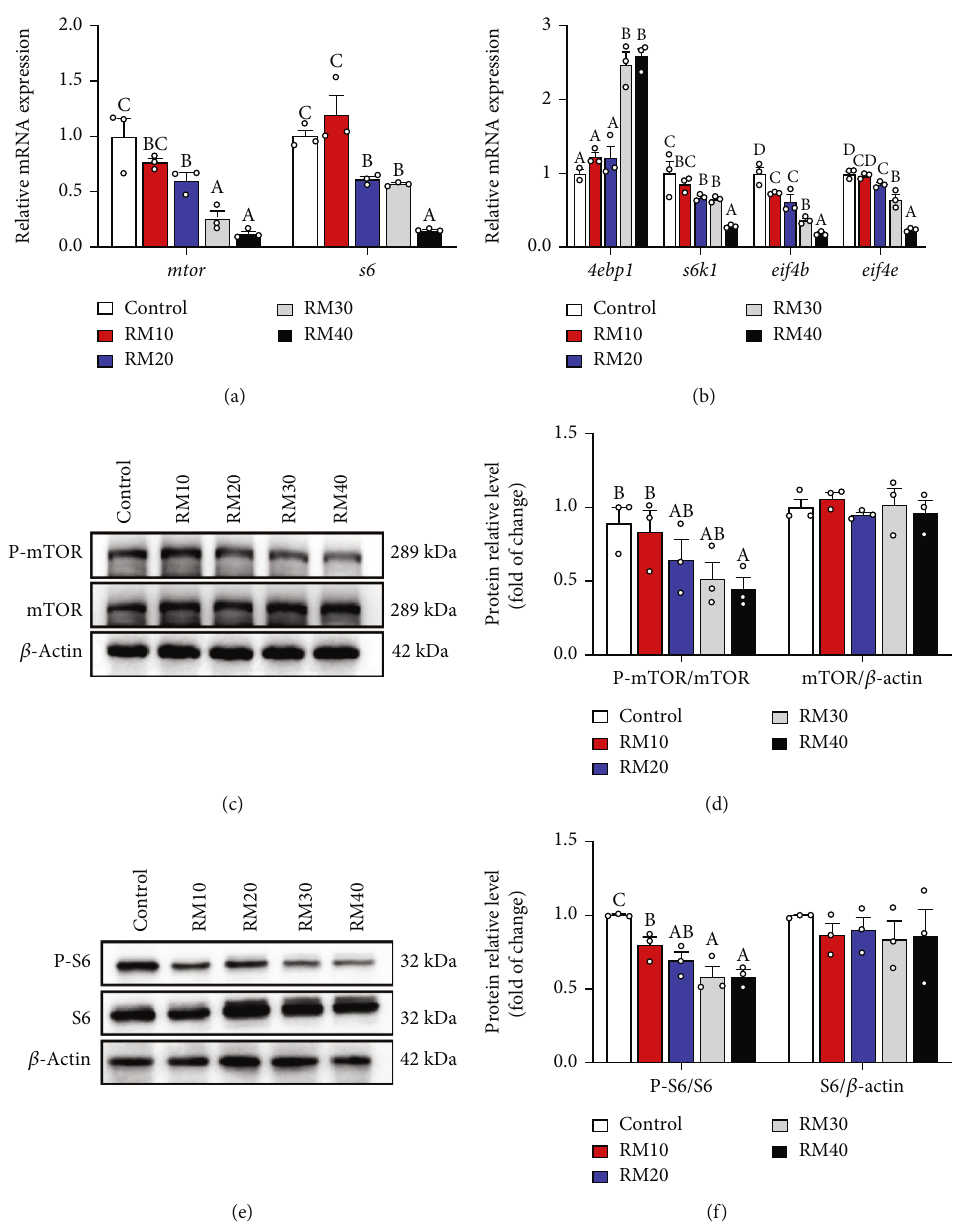
Figure 5: E ff ects of fi sh meal replacement by mixed plant protein on mTOR pathway in the liver of yellow cat fi sh. (a) Western blot and protein level of mTOR and p-mTOR. (b) Western blot and protein level of S6 and p-S6. (c) Relative mRNA expression of mTOR and S6. (d) Relative mRNA expression of mTOR pathway related genes. Values are means ± S.E.M. ( n = 3 ). Letters (a – d) denote signi fi cance P < 0 : 05 (One-way ANOVA, Duncan post hoc